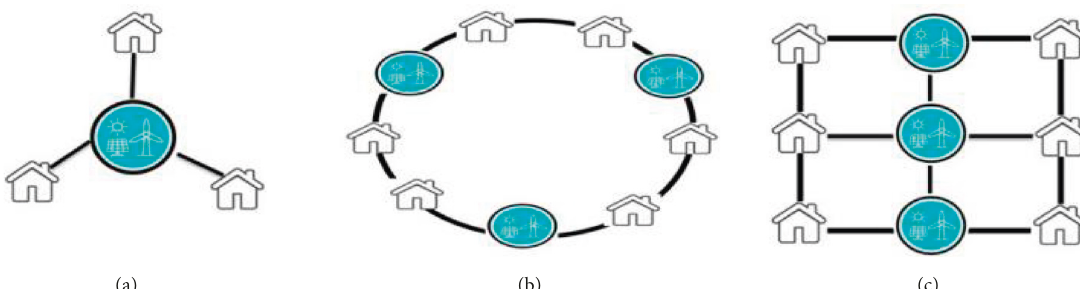
Figure 2: Decentralized smart grid topologies: (a) star with a central node as producer; (b) ring topology with decentralized 3 producer and 6 consumer nodes; (c) lattice topology with 3 producer and 6 consumer